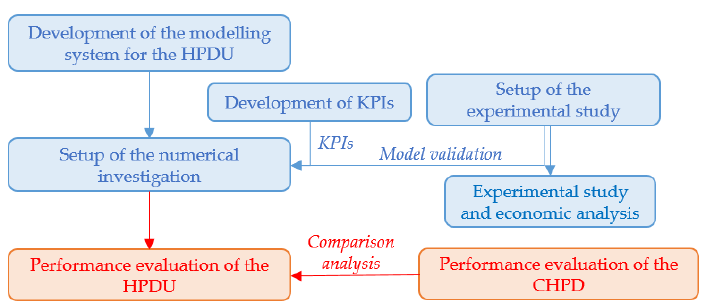
Figure 5. Research methodology used in this study.